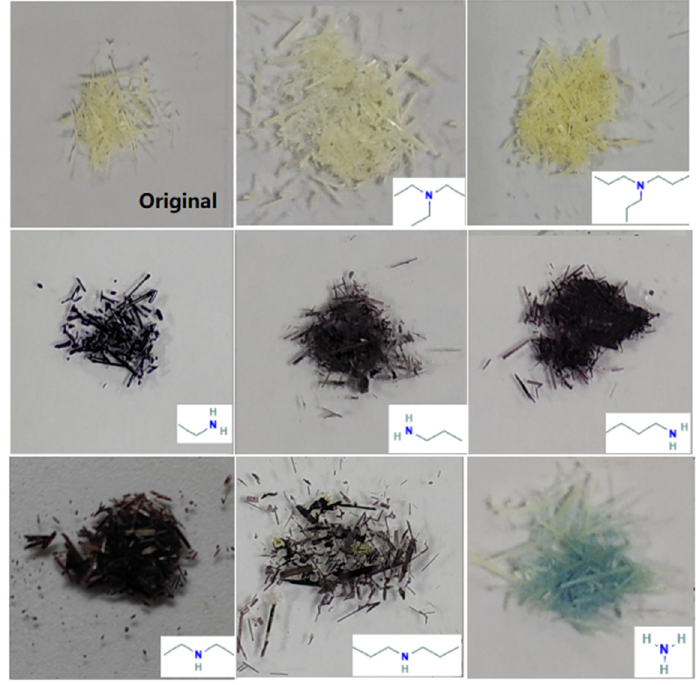
Figure 4. Photographs of compound 1 before and after exposure to different volatile amine vapors.